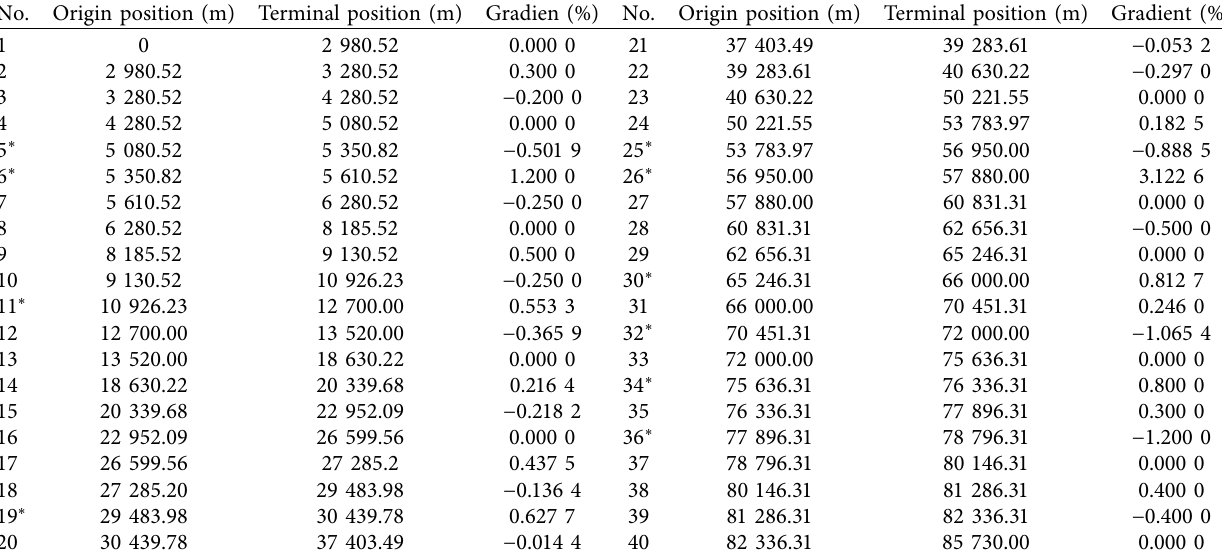
Figure 13: ASA layout considering the two directions coordinately for the ideal Table 1: Basic data of the test line.